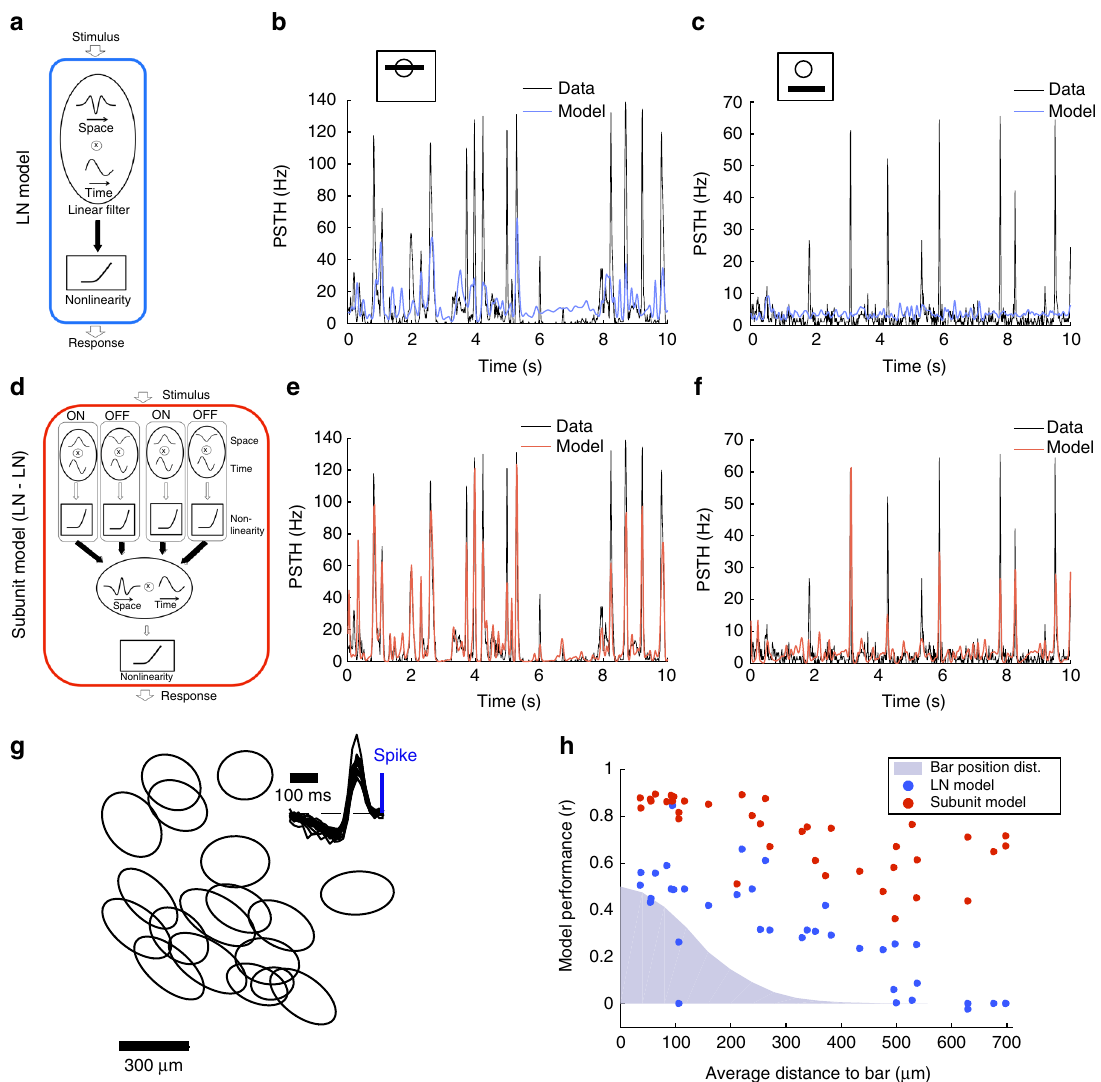
Fig. 3 Responses of ON ganglion cells to the randomly moving bar. a Schematic of the LN model, composed of a linear fi lter and static nonlinearity. Filled arrows correspond to learned weights of the model. b Response (PSTH, black) of a ganglion cell whose receptive fi eld center is stimulated by the bar, is not well predicted by the LN model (blue). r = 0.56. c Response (PSTH, black) of the same ganglion cell when the bar is far from the receptive fi eld center, is not predicted well by the LN model (blue). r = 0.01. d Schematic of the subunit model, composed of a fi rst stage (each subunit linearly fi lters the stimulus and applies a static nonlinearity), followed by weighted linear pooling and a second nonlinearity (see Methods section for details). Filled arrows correspond to learned weights of the model. e Response (PSTH, black) of the same ganglion cell (as in b , c ) to central stimulation is predicted well by the subunit model (red). r = 0.9. f Response (PSTH, black) of the same ganglion cell (as in b , c ) to distant stimulation is predicted well by the subunit model (red). r = 0.77. g Receptive fi elds of a population of ON ganglion cells of the same type. Each ellipse represents the position and shape of the spatial receptive fi eld associated with one cell (1-SD contour of the 2D Gaussian fi t to the spatial pro fi le of the RF). Inset: temporal pro fi les of the receptive fi elds of the same cells. h Performance of the LN (blue) and subunit (red) models in predicting ganglion cell responses, as a function of the distance of the cell to the bar. Blue shade: position distribution of the